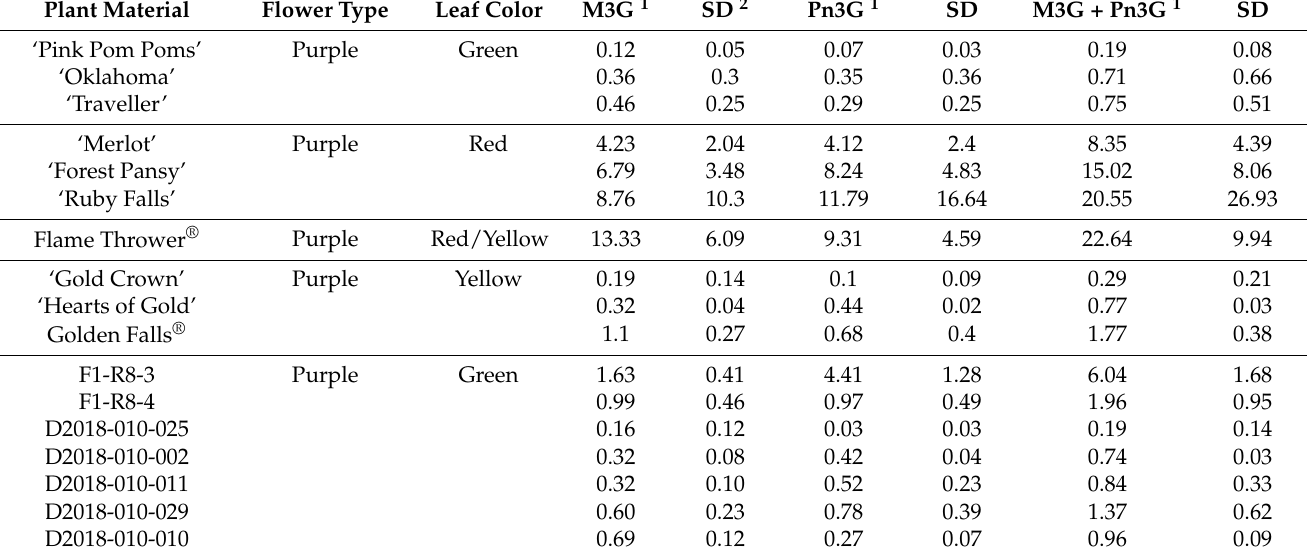
Table 2. Average Content of Peonidin-3-Glucoside and Malvidin-3-Glucoside in Petiole Tissue of Eastern Redbud ( Cercis canadensis L.) determined by